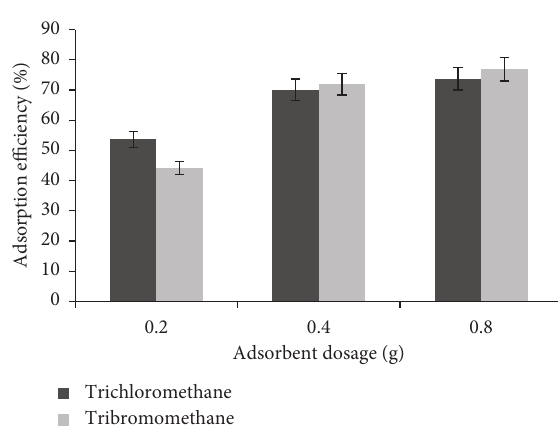
Figure 4: Effect of adsorbent dosage on adsorption of trichloro- methane and tribromomethane in simulated